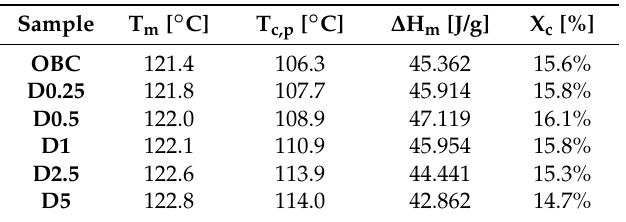
Table 1. Melting temperature (T m ), crystallization peak temperature (T c,p ), enthalpy ( ∆ H m ), and